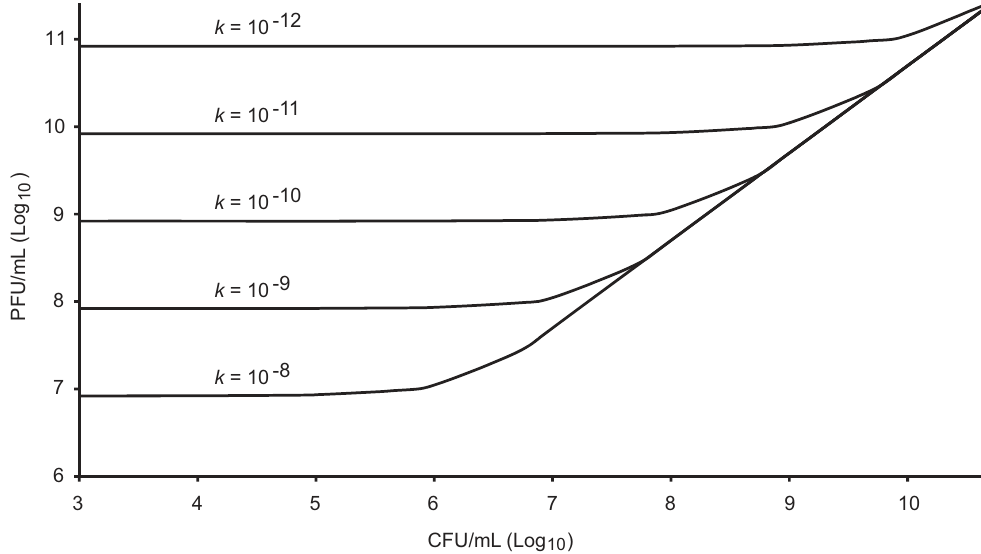
Figure 2. Phage titre needed to reach an actual multiplicity of infection (MOI actual ) of five after 1h of infection at different adsorption rate constants ( k ¼ adsorbed phages/mL min), and as a function of the bacterial titre, in an ideal pelagic system. At MOI actual ¼ 5, the probability that a bacterium gets infected is 0.99. The func- tions converge to the diagonal line when MOI actual ¼ MOI input . For example, at a CFU/mL of 10 8 , a MOI input of 5 equals MOI actual if the adsorption rate is higher than 10 (cid:3) 9 , but if it is lower than 10 (cid:3) 12 a MOI input of about 1000 (10 11 PFU/mL) is needed. Function values are constant at lower CFU/mL where MOI input has to be substantially higher especially if the adsorption rate is